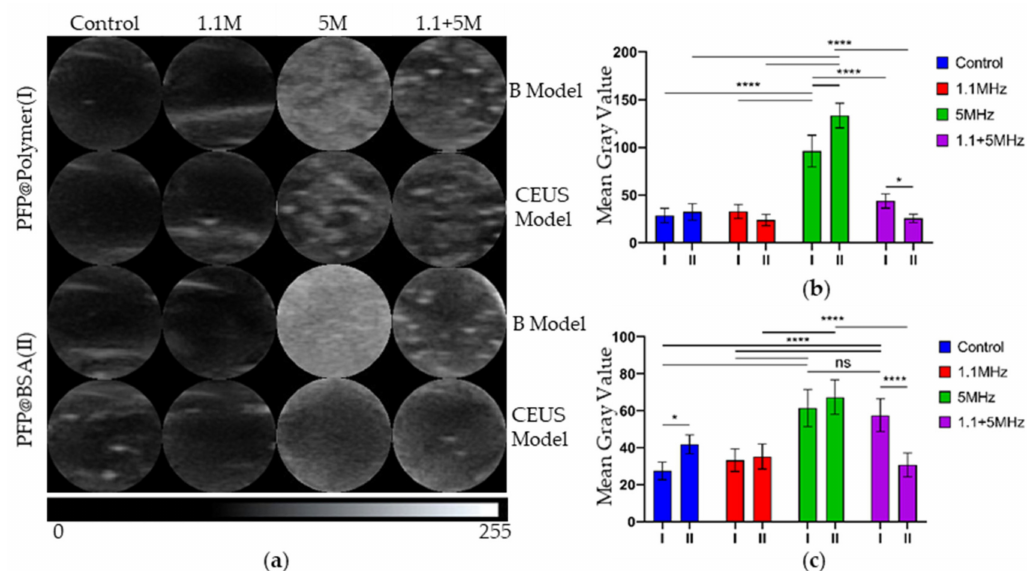
Figure 5. In vitro US imaging performance. ( a ) B-mode and contrast-enhanced ultrasound (CEUS) imaging of PFP@Polymer nanoparticles after 1.1 MHz, 5 MHz, and 1.1 + 5 MHz HIFU irradiation (1.1 MHz: 10 W, 6 ms, and 100 Hz; 5 MHz: 10 W, 100 µ s, and 100 Hz) for 20 s in gel phantoms. The same concentration of PFP@BSA nanodroplets was used as that of controls. The mean US intensity values in both ( b ) B mode and ( c ) CEUS mode images with PFP@Polymer nanoparticles (I) and PFP@BSA nanodroplets (II) in different modes of HIFU irradiation. The diameter of the circular area is 1 cm. * p < 0.05 and **** p <